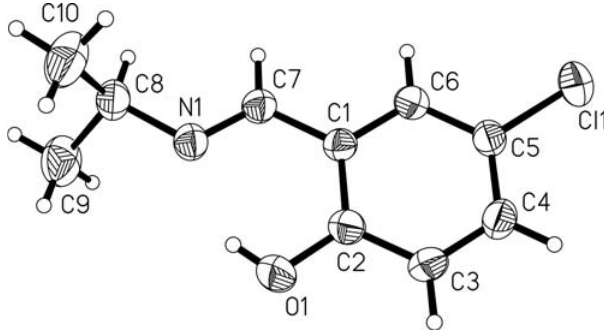
Table 1. Data collection and handling.